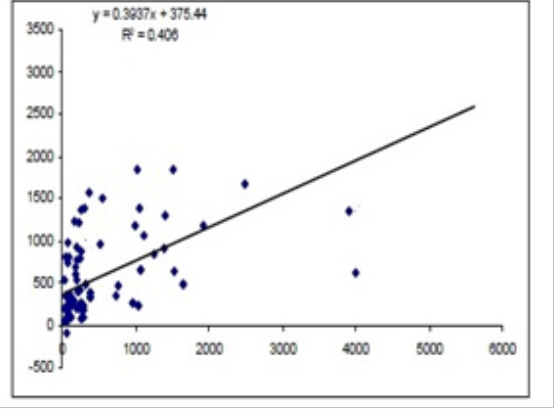
Figure 3 - Sediment curve Sierra